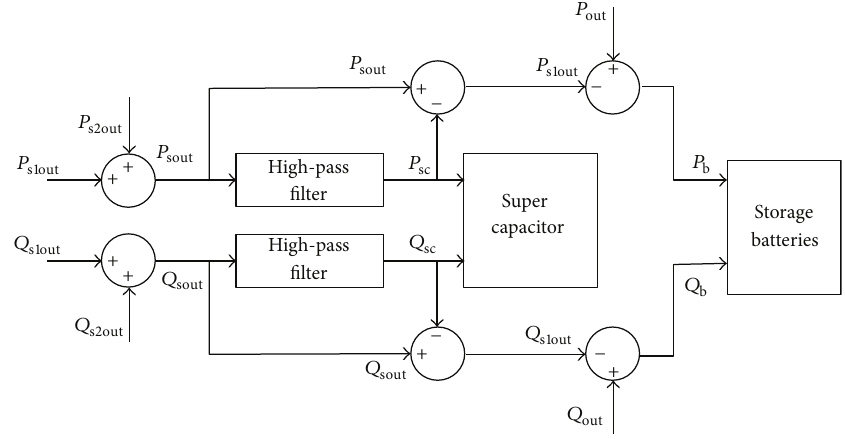
Figure 6: Hybrid energy storage control